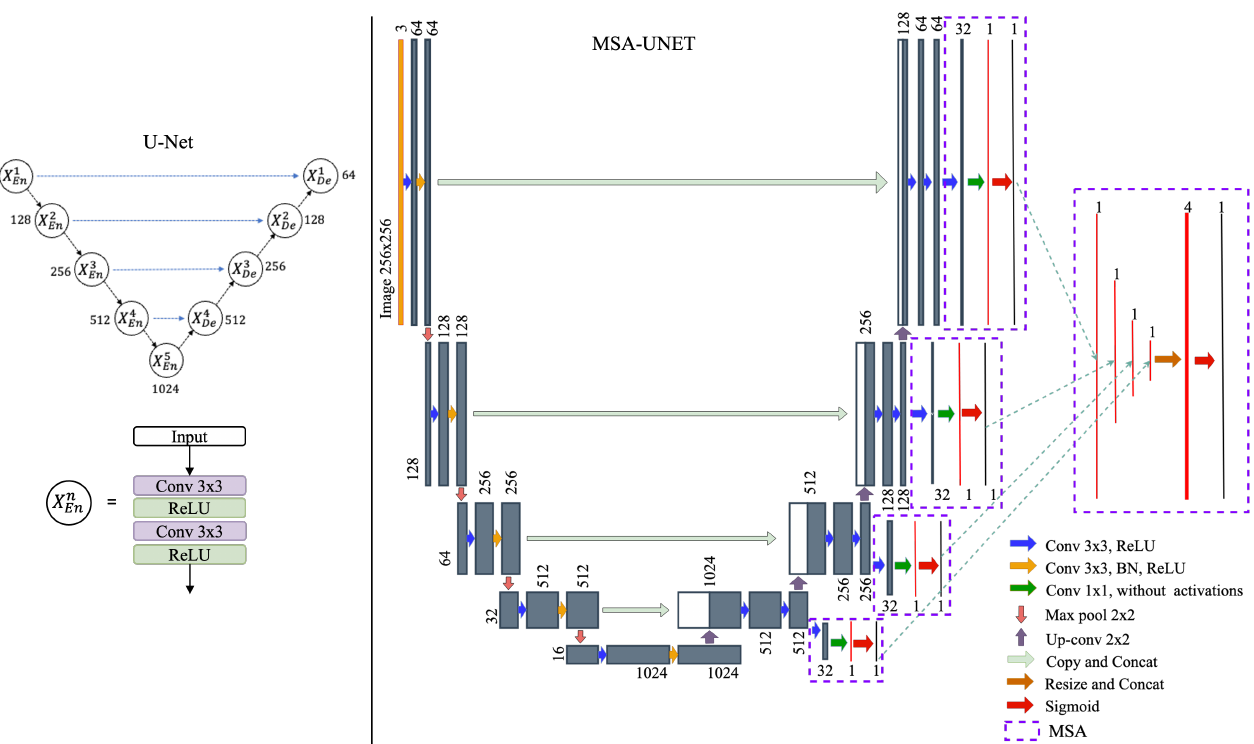
Figure 3. Network architecture of U-Net (left) and the proposed MSA-UNET (right). The MSA-block of the proposed MSA-UNET inherits the multi-scale features from the last layer of each (among four) decoder block of U-Net, and applies 3 × 3 convolutions with ReLU activation function and a 1 × 1 convolution with sigmoid function to produce a segmented map. The maps of all four scales are then aggregated by (i) re-sizing them to input image size, (ii) concatenating together, and (iii) applying a 1 × 1 convolution with a sigmoid activation function to obtain the final